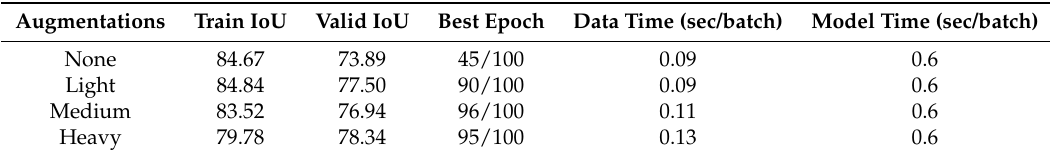
Table 2. Results for different augmentation levels for the segmentation task on the Inria Aerial Image training (higher is better). Data time and Model time indicate how long it takes to preprocess a batch of images and then run it through the network (lower is